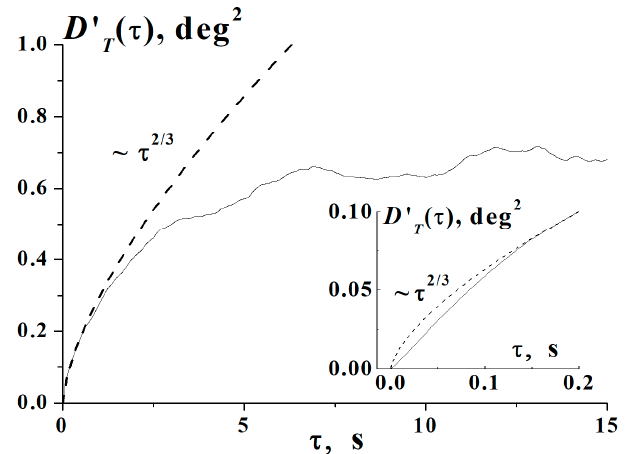
Figure 5. The experimental structure function of temperature fluctuations of D ′ T ( τ ) (solid line). In the inset at the lower right, its initial part is increased with a small separation, τ , showing behavior different from the Kolmogorov “2/3” asymptotic. Sayan, 19.07.2017.